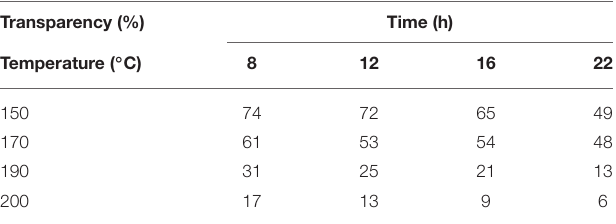
TABLE 3 | Transparency values (as the total transmittance at 600nm) for polyaleuritate films as a function of the preparation conditions. Transparency (%) Time (h) Temperature ( ◦ C)